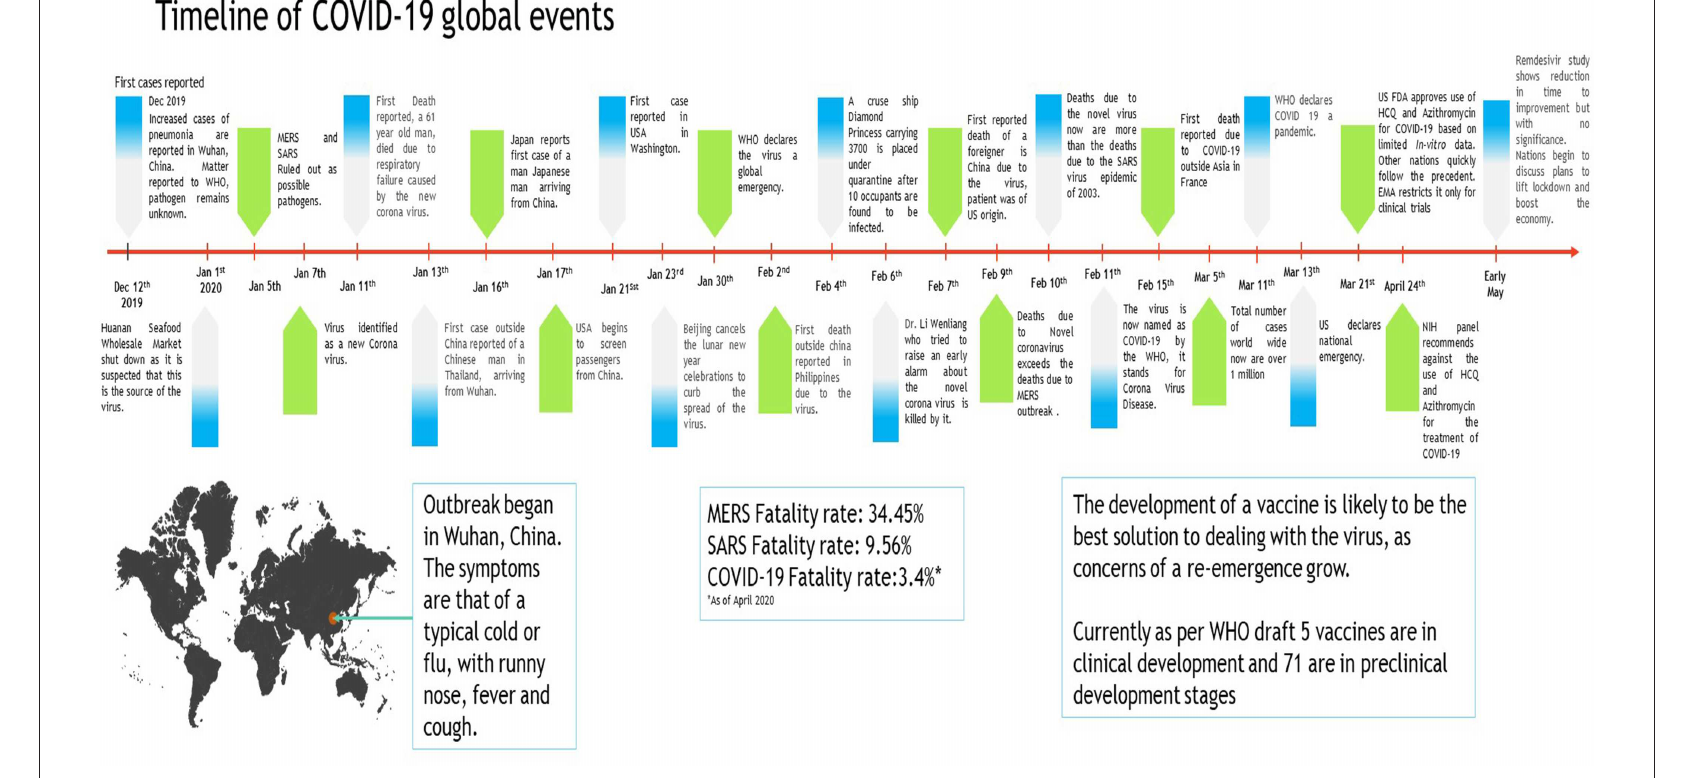
FIGURE 1 | Timeline of COVID-19 progression